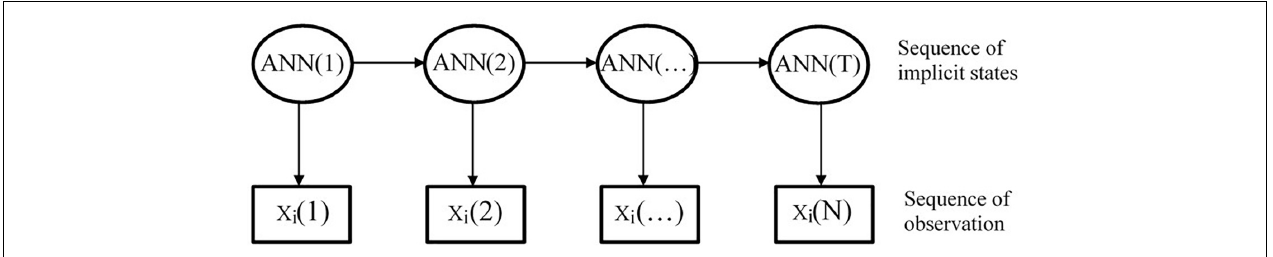
FIGURE 3 | Hidden Markov model/artificial neural network